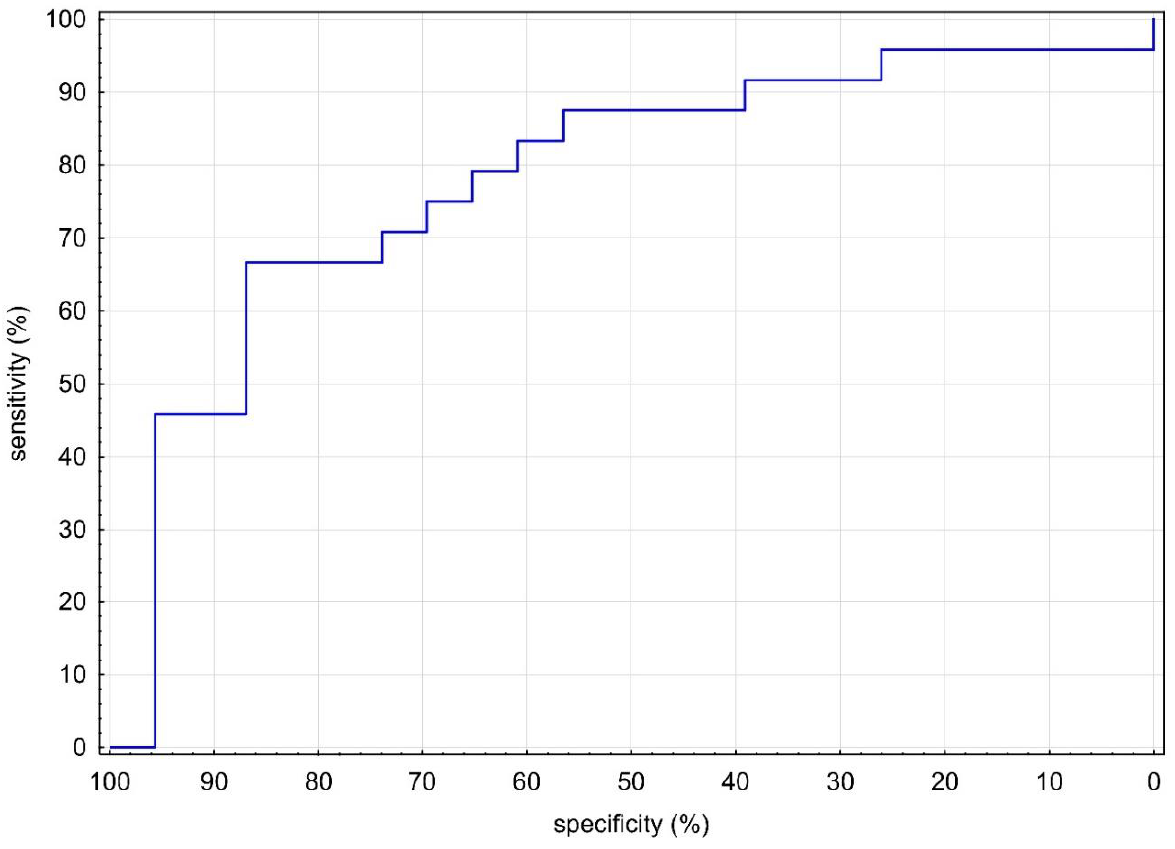
Figure 2. ROC curve of RHI levels between MIS-C and HI. HI: healthy individuals; MIS-C: multisystem inflammatory syndrome in children; RHI: reactive hyperemic index. Table 6. MIS-C: biomarkers, cardiac, and laboratory parameters, and correlations with RHI and Cys C.